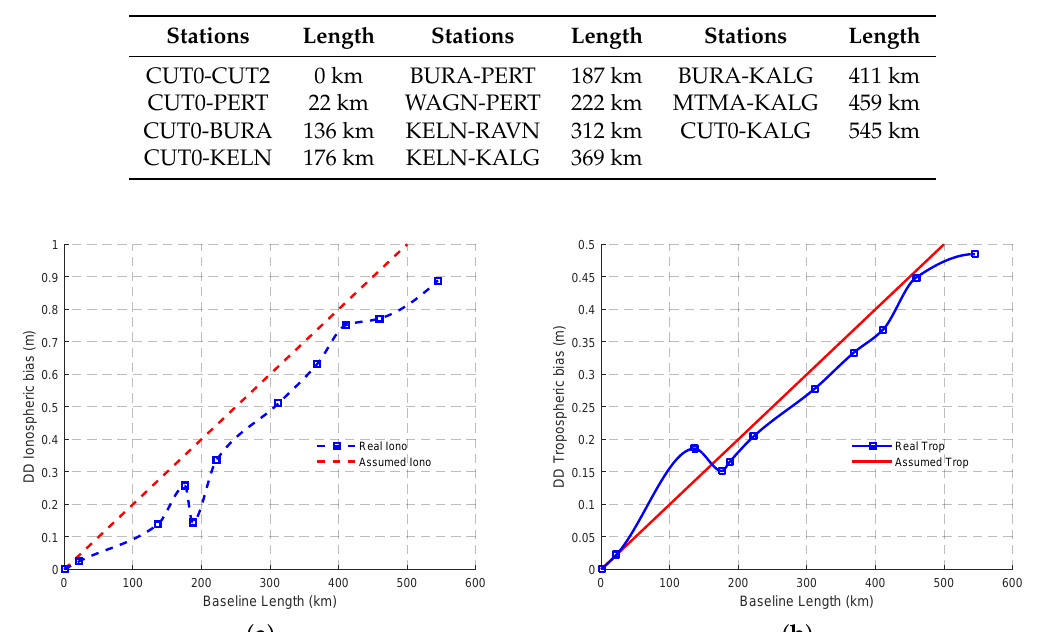
Table 7. The length of baselines.